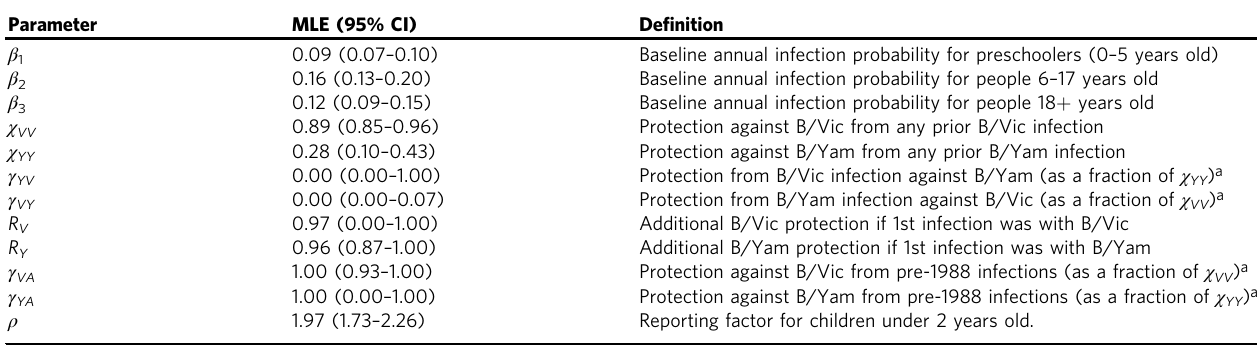
Table 2 Parameter estimates for the model fi tted to the New Zealand case